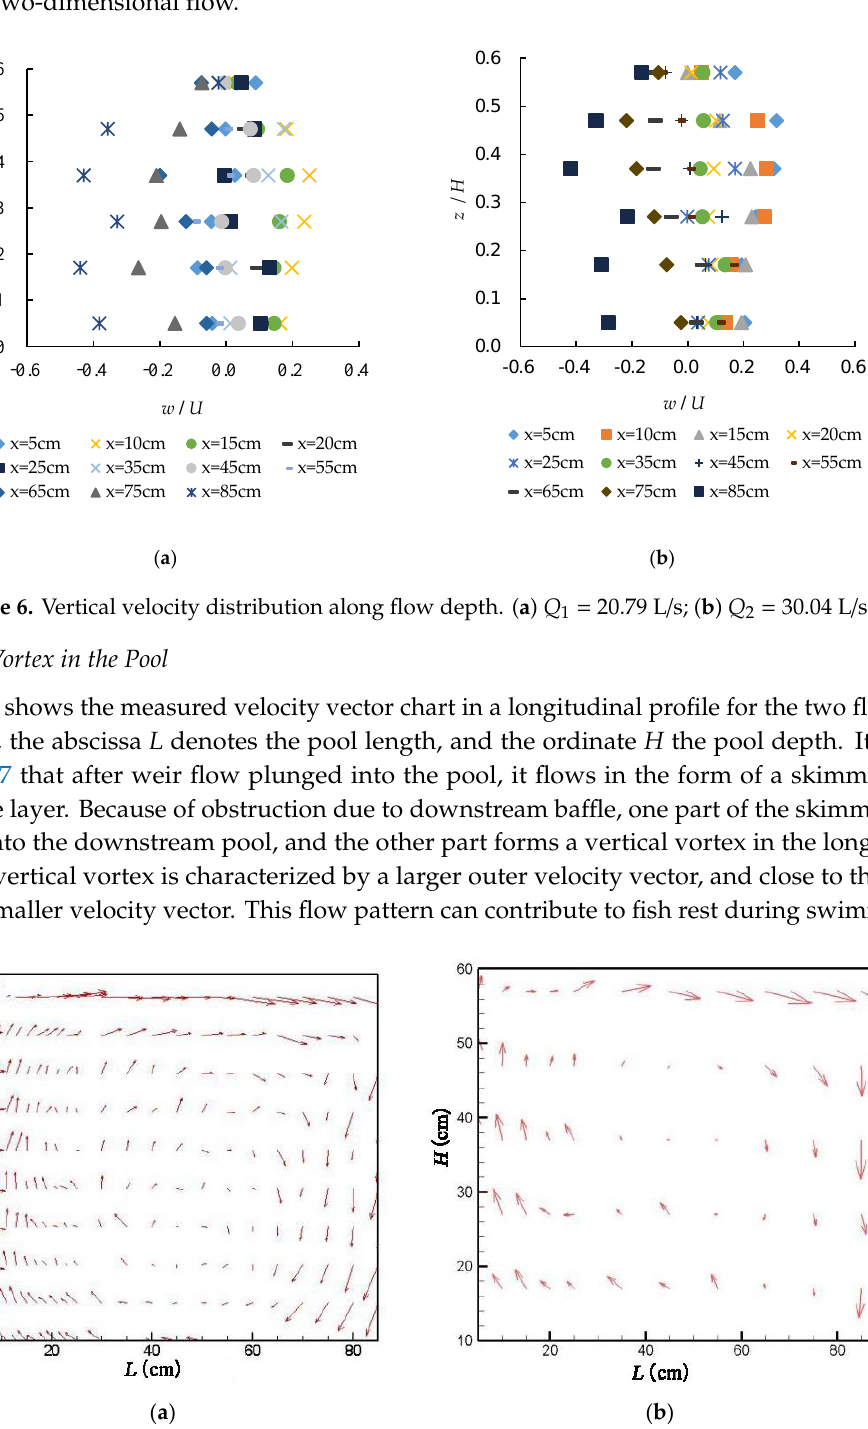
Figure 7. Velocity vectors on the xoz plane.( a ) Q 1 = 20.79 L/s; ( b ) Q 2 = 30.04 L/s.